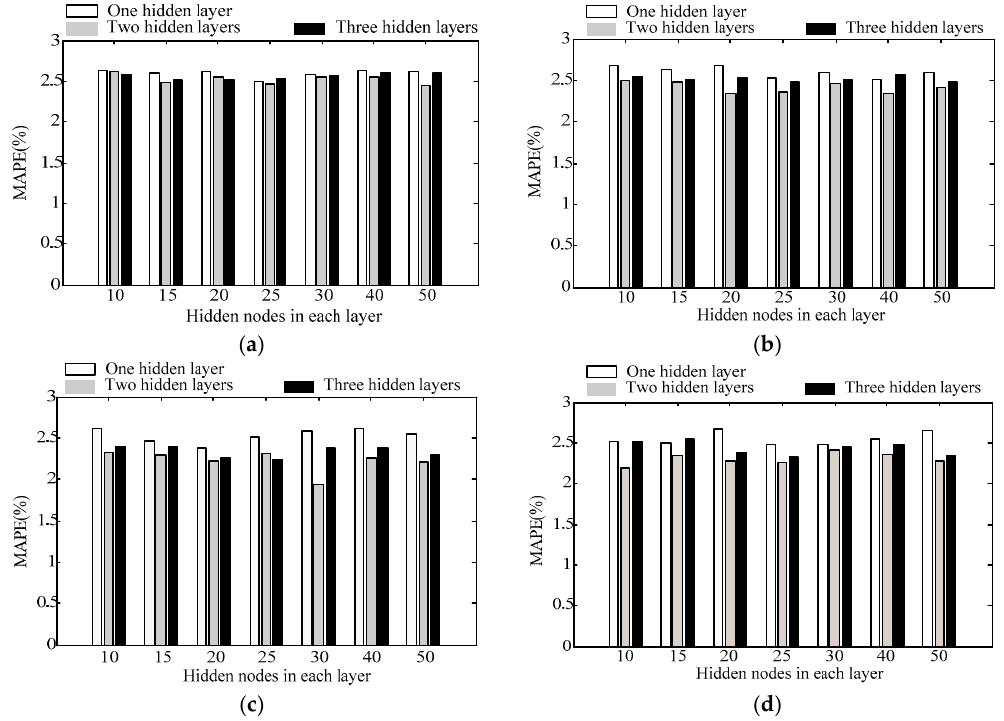
Figure 4. Testing results of different MDRN models with different K : ( a ) K = 8, ( b ) K = 10, ( c ) K = 12, and ( d ) K = 14.